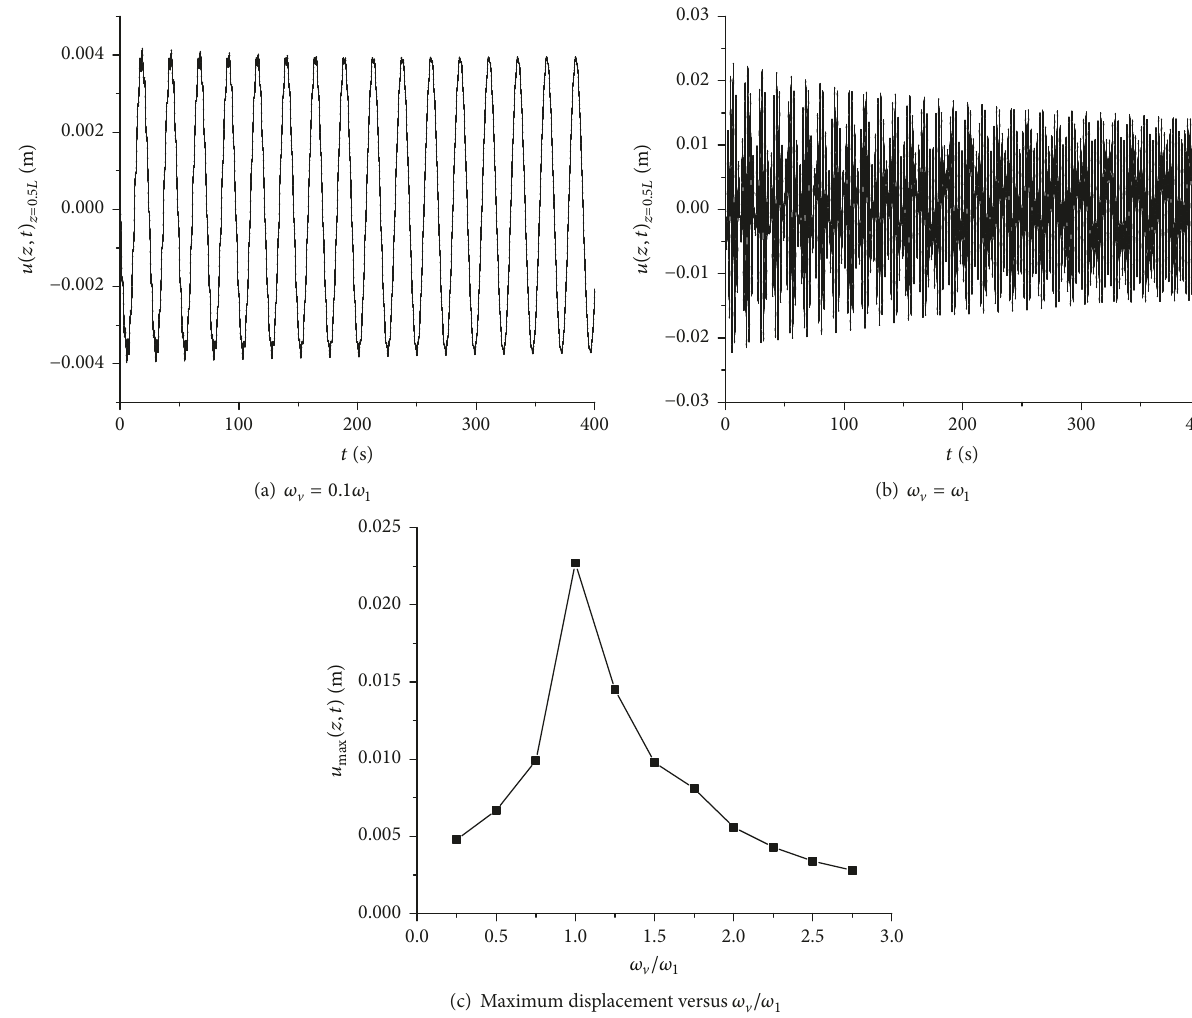
Figure 6: Dynamic response of the cable under only vortex